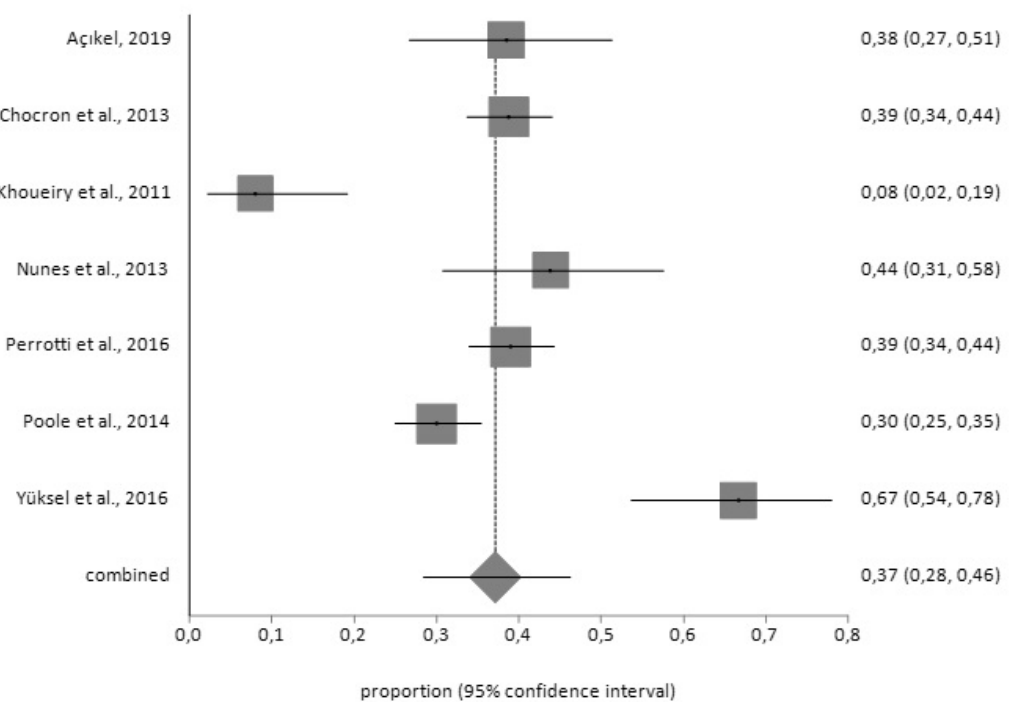
Figure 3. Forest plot for post-CABG depression using HADS.